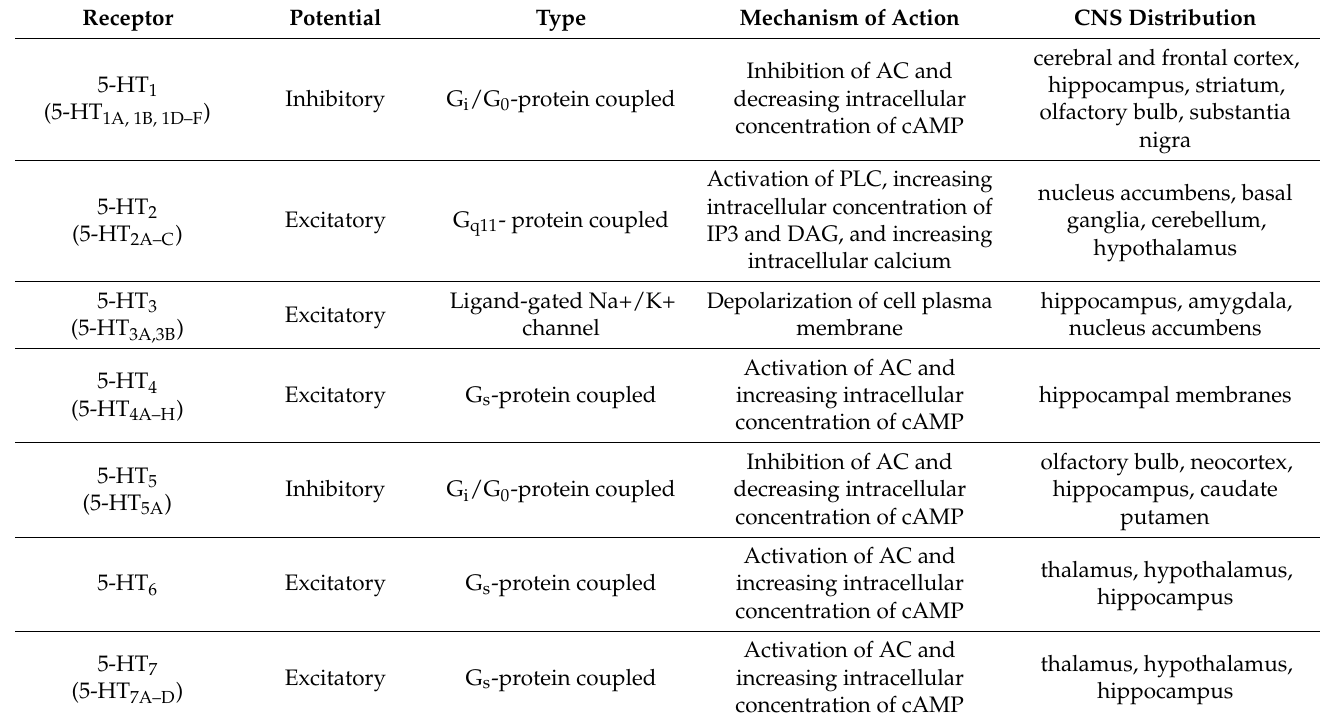
Table 1. The family of 5-HT receptors. Prepared based on